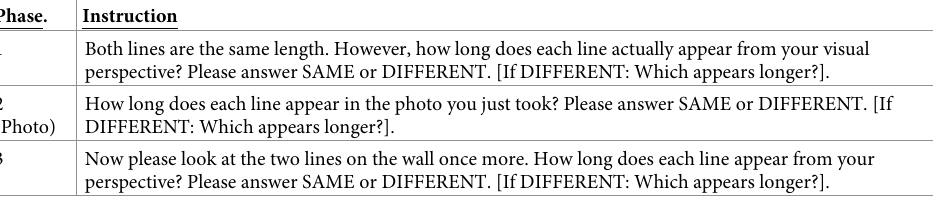
Table 1. Scripted instructions to participants.